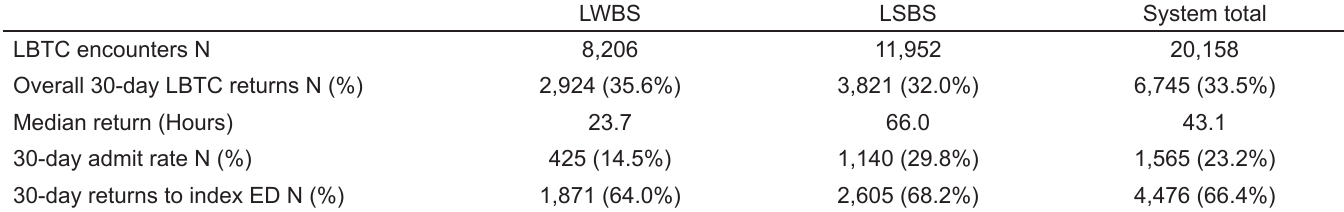
Table 2. Comparing patients who left without being seen vs patients who left subsequent to being seen.